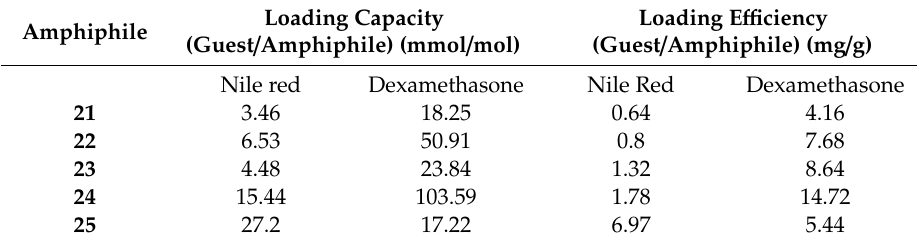
Figure 5. Guest loading capacity (mmol / mol) and guest loading e ffi ciency (mg / g) of amphiphiles 21–25 for Nile red and dexamethasone. Table 4. Loading capacity and loading e ffi ciency of amphiphiles 21–25 .